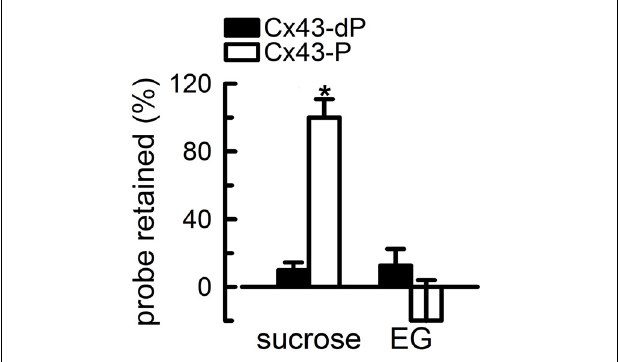
FIGURE 4 | Partial closure of Cx43 hemichannels by PKC-mediated phosphorylation. The proteoliposomes were loaded with radiolabeled probes, and the % retention was measured after gel filtration. The proteoliposomes contained HCs formed by either Cx43-dP or Cx43-P. Reconstitution was at an average of 2.3 HCs/liposome. Data are means ± s.e.m. of 4–7 experiments. The asterisk denotes P < 0 . 05 compared with proteoliposomes containing Cx43-dP HCs. Modified from Bao et al.,